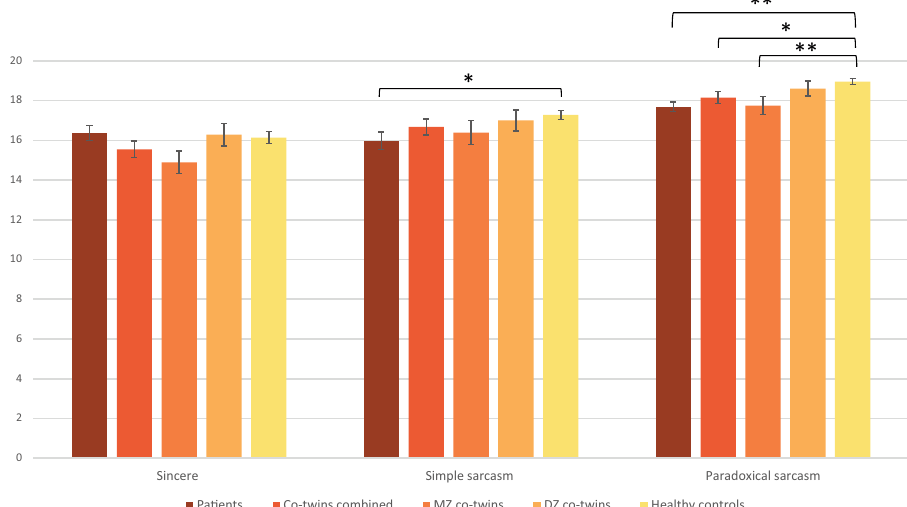
Fig. 1 Average TASIT performance. TASIT performance for patients, their unaffected co-twins (combined and split on zygosity) and healthy control twin pairs showing the average number of correct responses. Error bars represent the standard error of the mean (SEM). *signi fi cant at p = 0.05, ** Signi fi cant after FDR